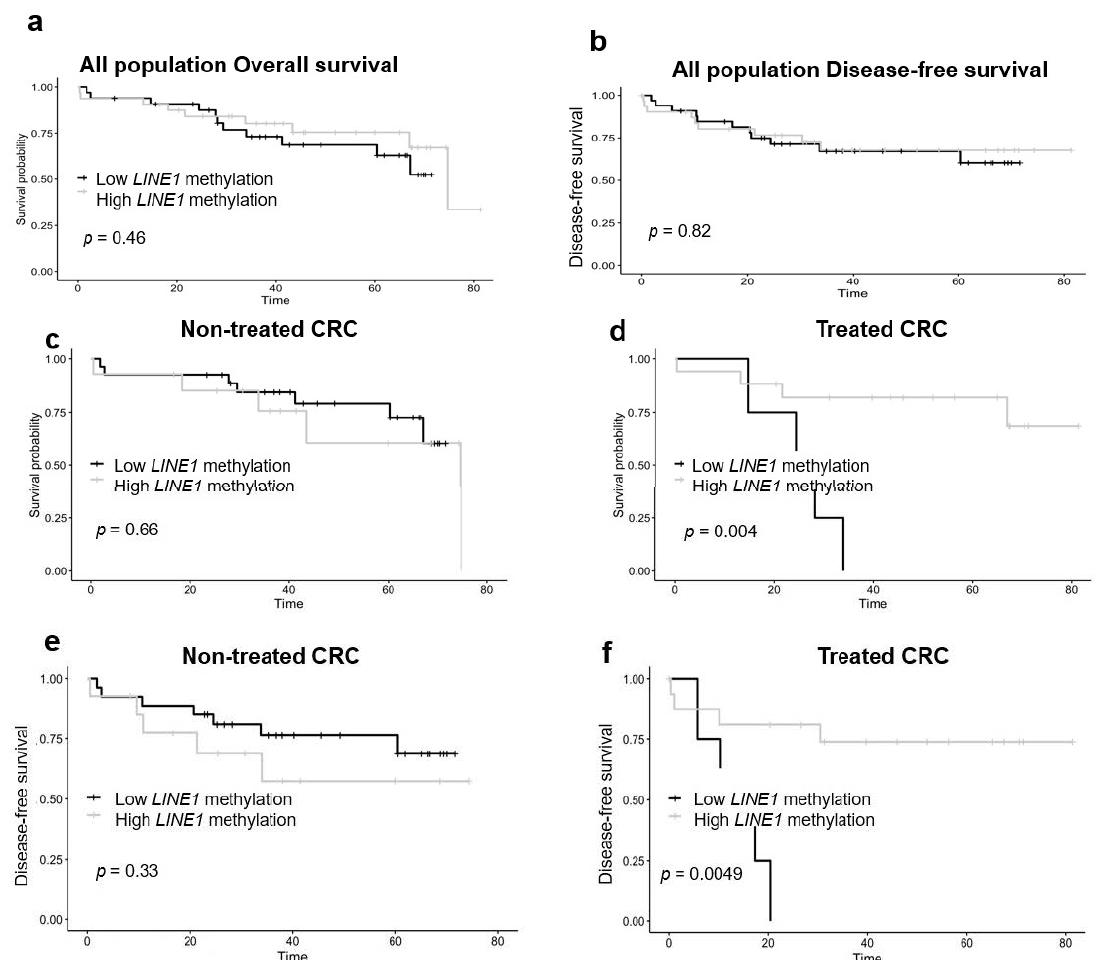
Figure 1. LINE-1 methylation and overall survival analysis according to the neoadjuvant treatment. Kaplan–Meier analysis was performed to determine overall and disease-free survival according LINE-1 methylation (low vs. high) of overall survival and disease-free survival of all populations ( a , b ), and non-treated ( c , e ) and treated patients ( d , f ). Significant di ff erences are conducted according to Wald test (p < 0.05). CRC—colorectal